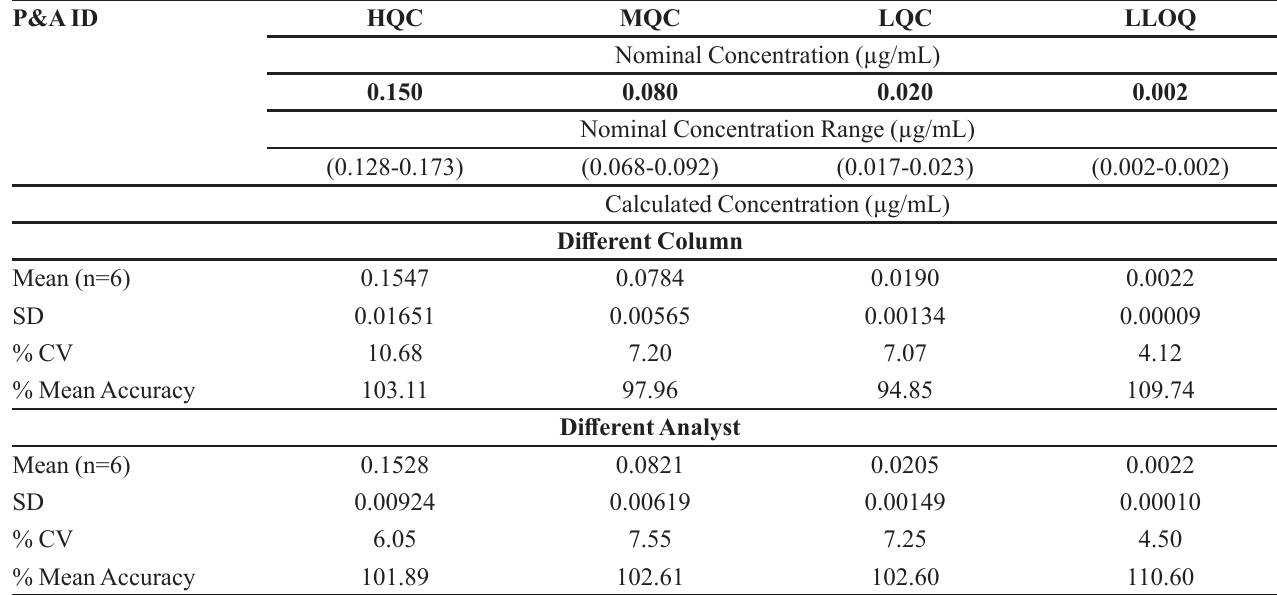
TABLE X - Ruggedness data